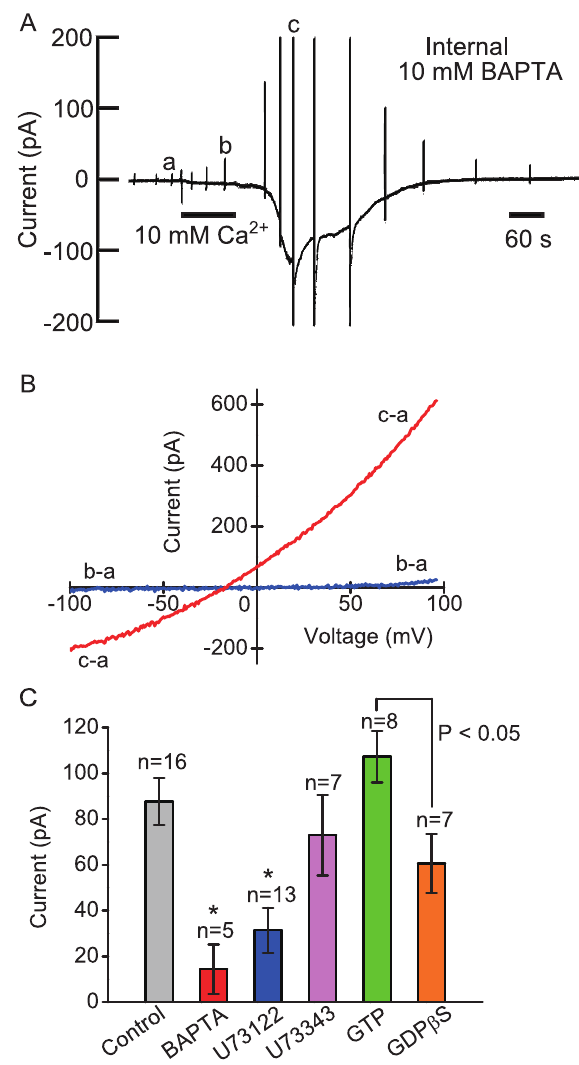
Figure 4. Effects of intracellular drugs on extracellular Ca 2 + - induced current. (A)The pen recording of the inhibitory effect of internal 10 mM BAPTA on extracellular Ca 2 + -induced current measured at 2 54 mV. (B) The plot of the whole-cell current/voltage ( I/V ) relationships produced by a voltage ramp. (C) Comparison of the effects of intracellular drugs on extracellular 10 mM Ca 2 + -induced current measured at 2 54 mV.